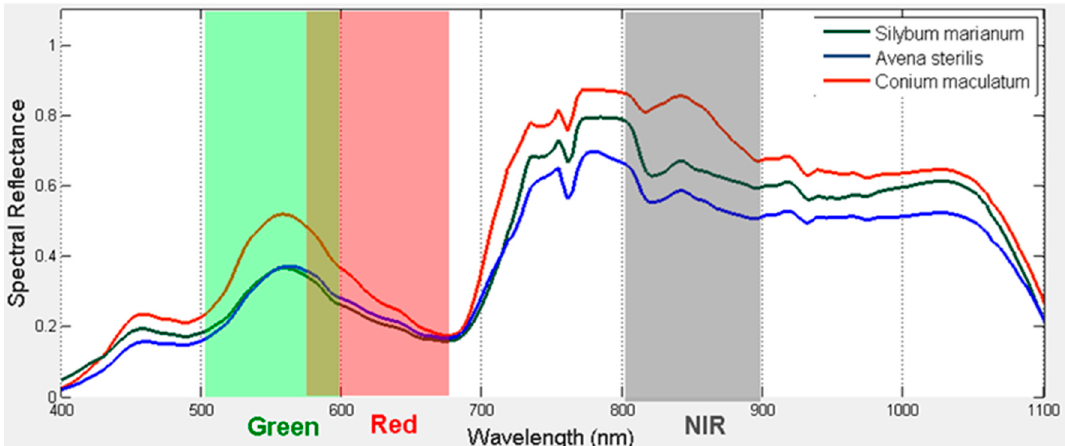
Figure 2. Vegetation species demonstrated similar spectral reflectance with Silybum marianum .